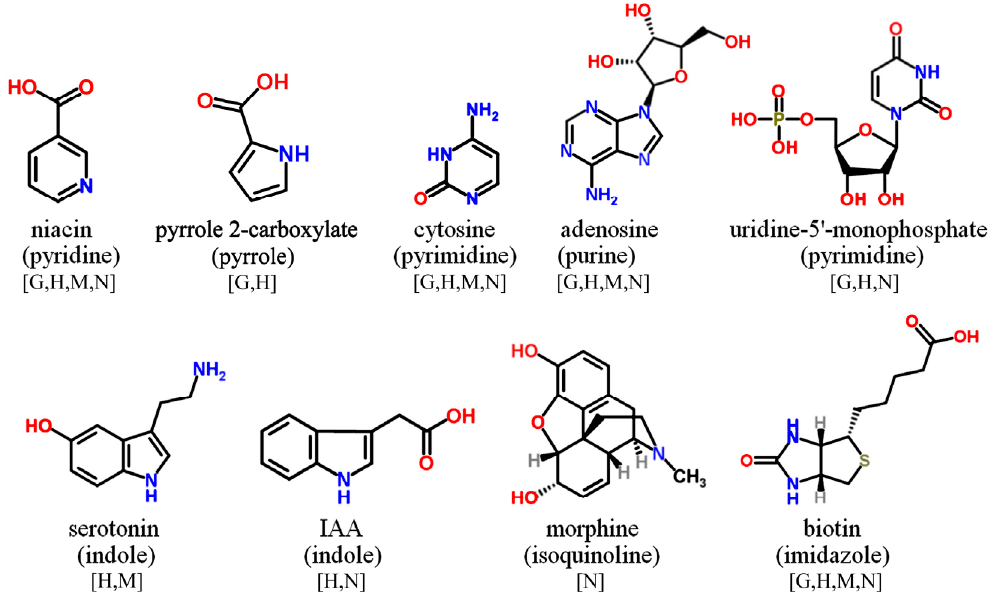
Figure 5. Selected N -containing cyclic compounds detectable in GC-MS profiling experiments. Names of the basic heterocyclic structures are given in brackets. MS spectra included in publically available